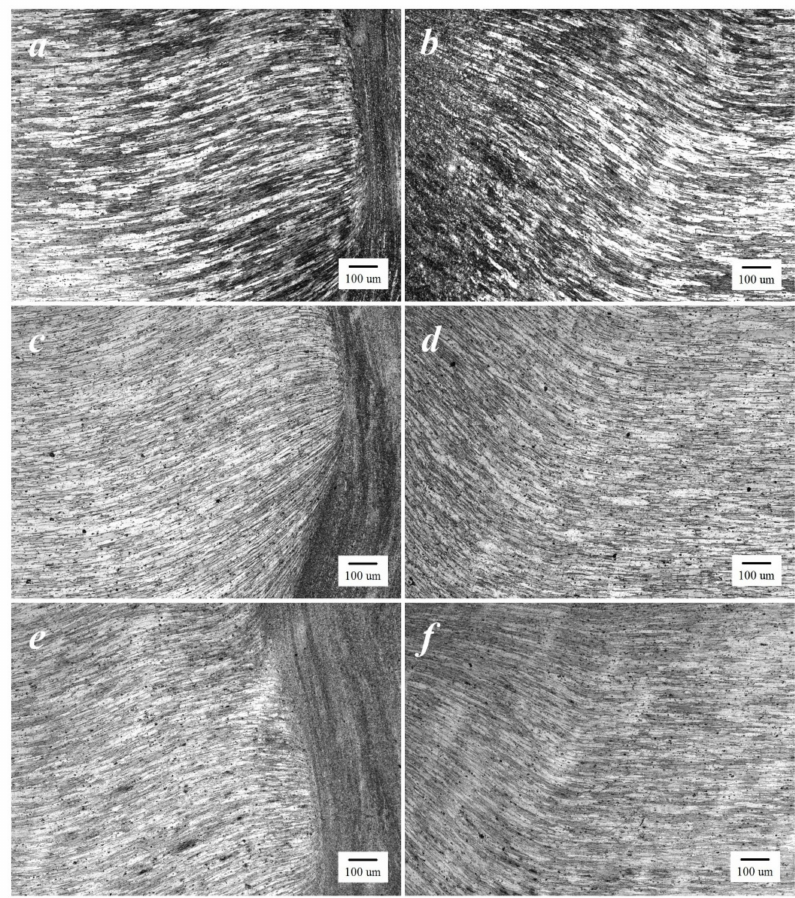
Figure 17. Microstructure at 50 × ( a ) thermo-mechanically a ff ected zone (TMAZ)-advancing side (AS) of FSW; ( b ) TMAZ-retreating side (RS) of FSW; ( c ) TMAZ-AS of FSW-DR-PWHT; ( d ) TMAZ-RS of FSW-DR-PWHT; ( e ) TMAZ-AS of FSW-PWHT-DR; and ( f ) TMAZ-RS of